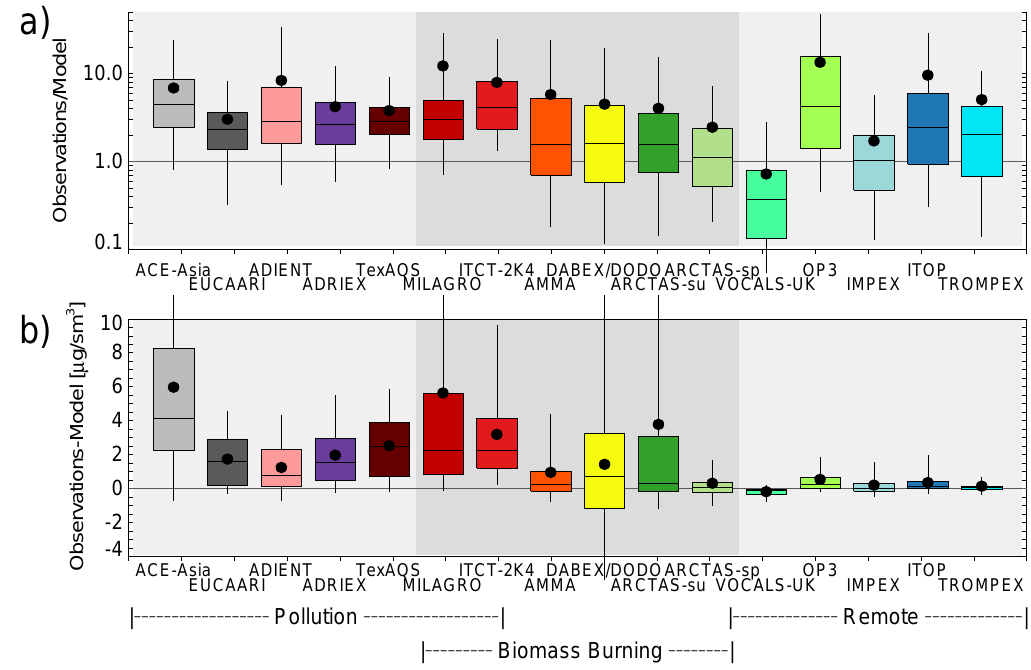
Fig. 6. Distribution of (a) ratio and (b) difference in observed and simulated (GEOS-Chem) OA concentrations for 17 field campaigns. Means of the gridded comparisons are shown as a solid dot, median as a horizontal line. The boxes denote 25th and 75th percentile, whiskers denote 5th and 95th